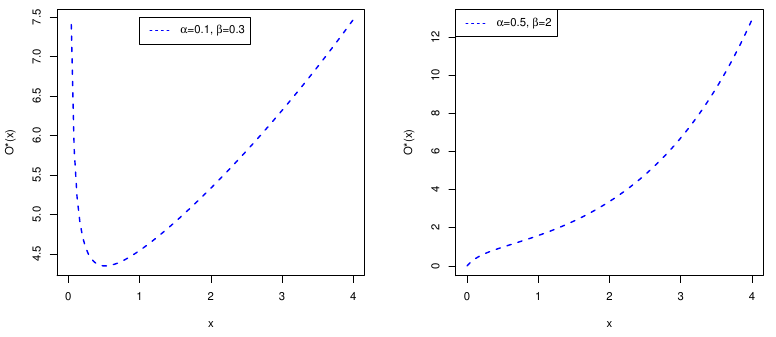
Figure 3. Some possible shapes for the O ∗ of the EBuH distribution.